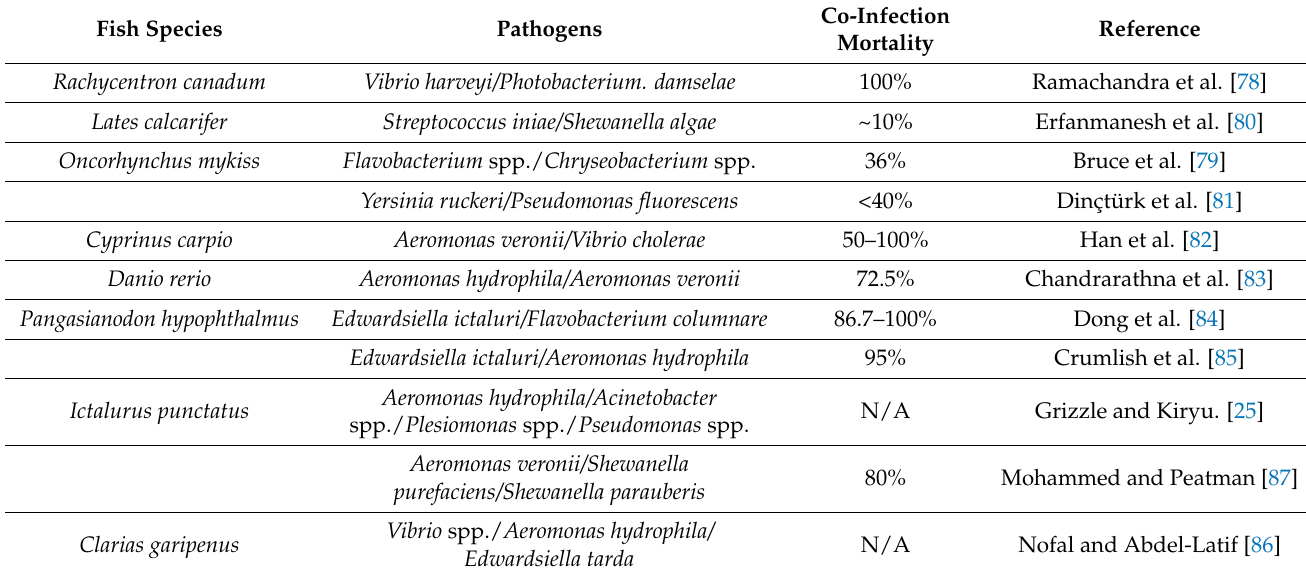
Table 2. Summary of bacterial co-infections discussed in this